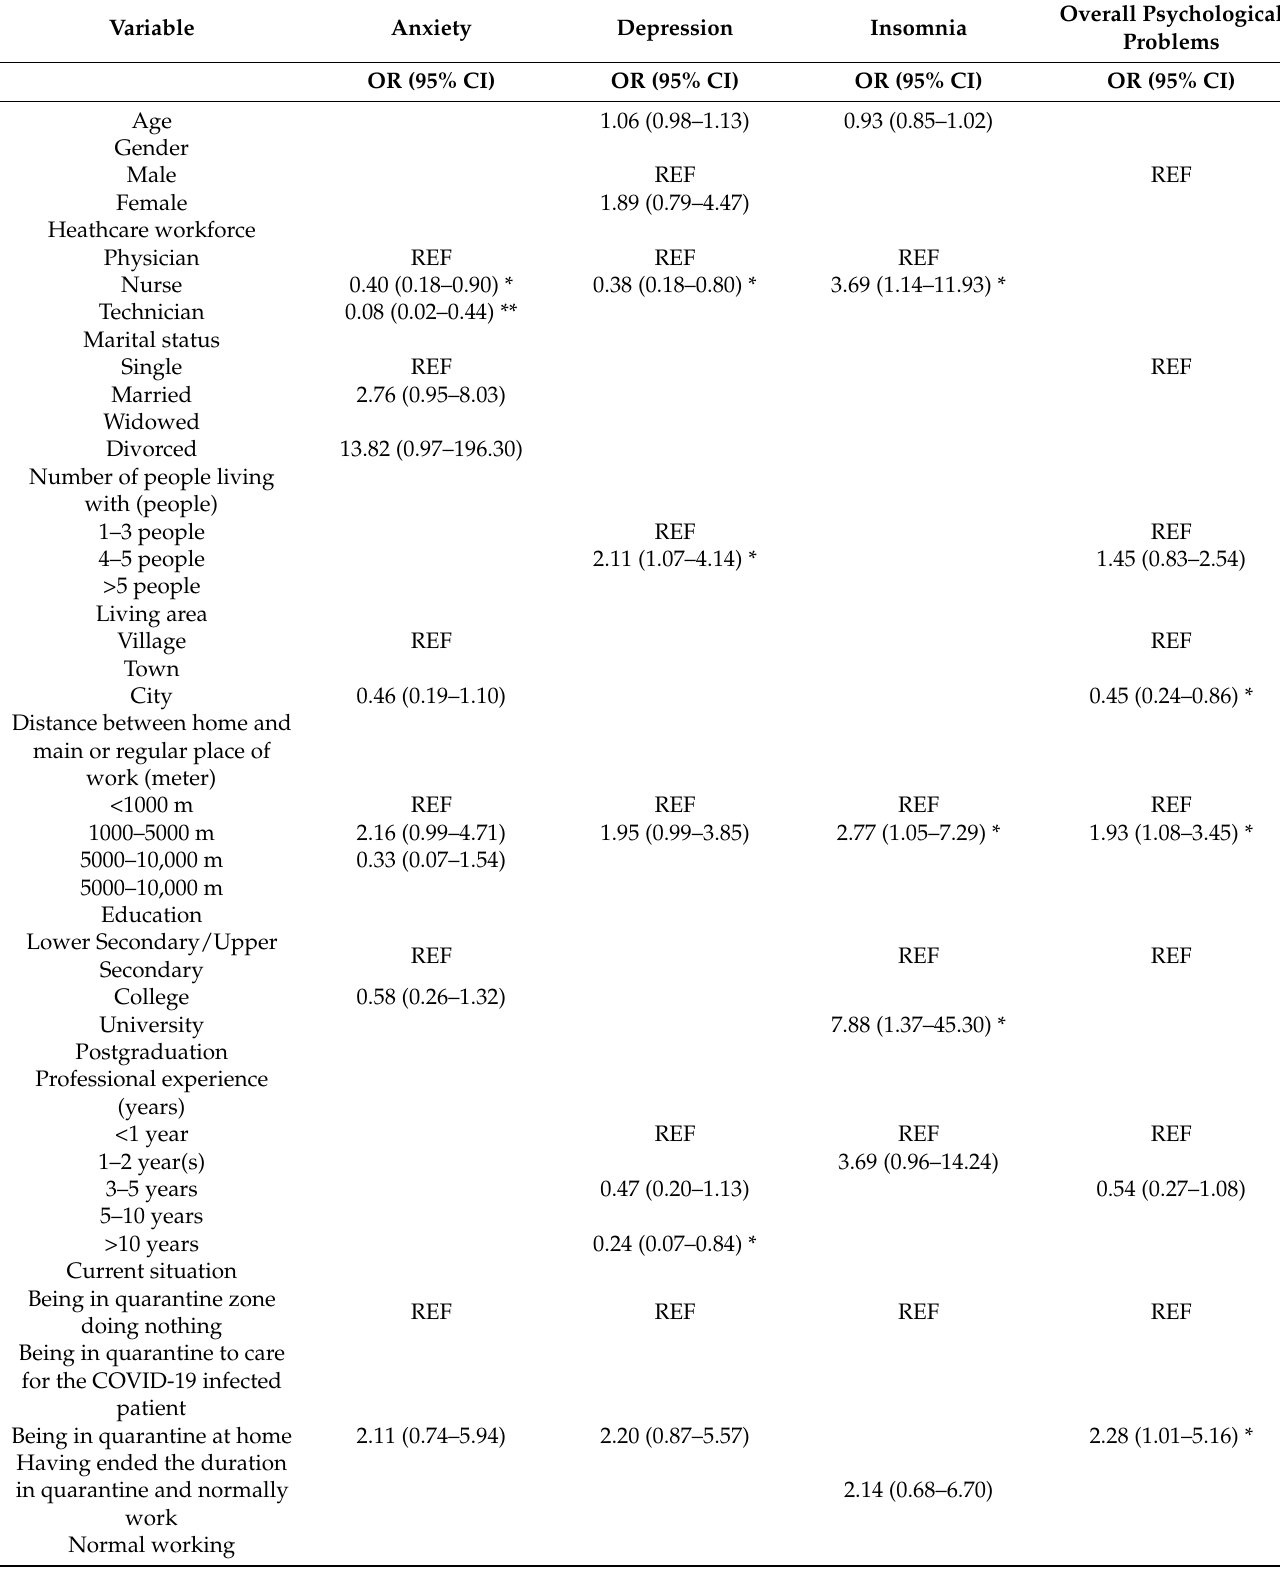
Table 4. Multivariable logistic regression analysis of the factors associated with psychological